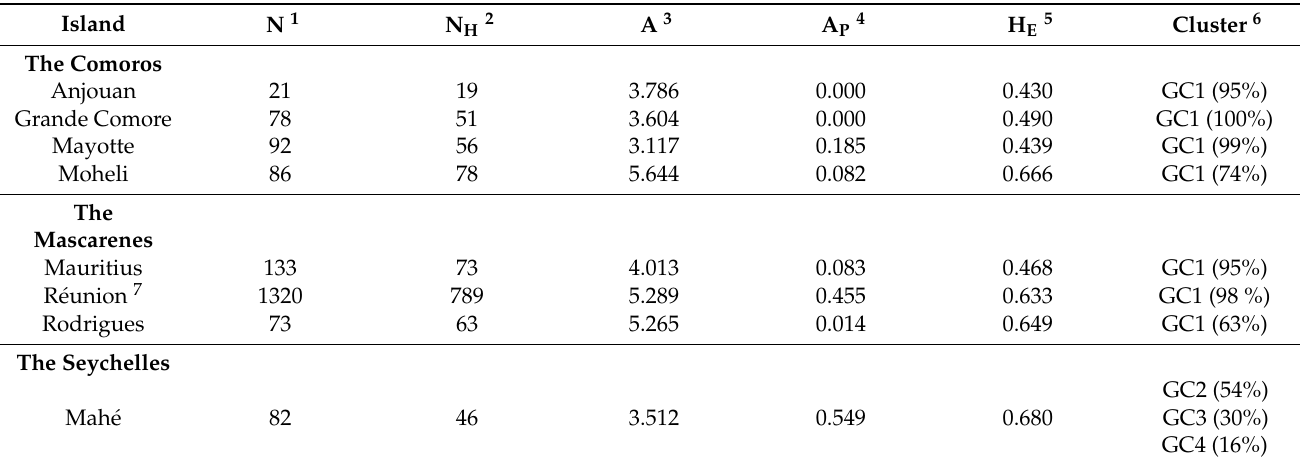
Table 1. Genetic diversity parameters calculated from microsatellite data (MLVA-14) for X. citri pv. citri pathotype A in the SWIO